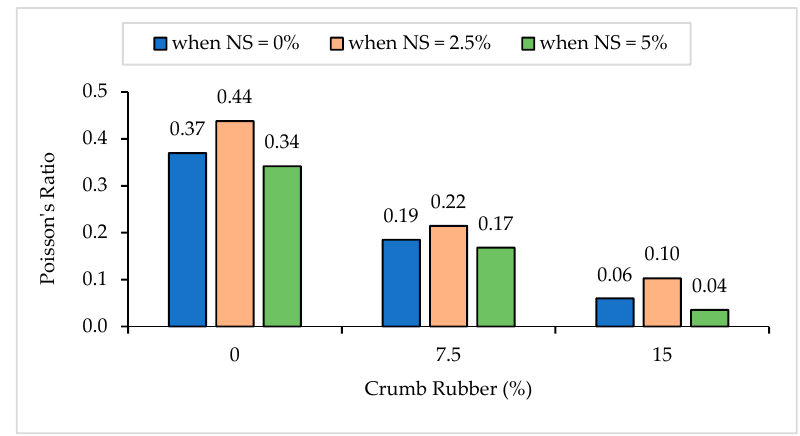
Figure 11. Poisson’s Ratio of NS-CRM mixes at 28 days.